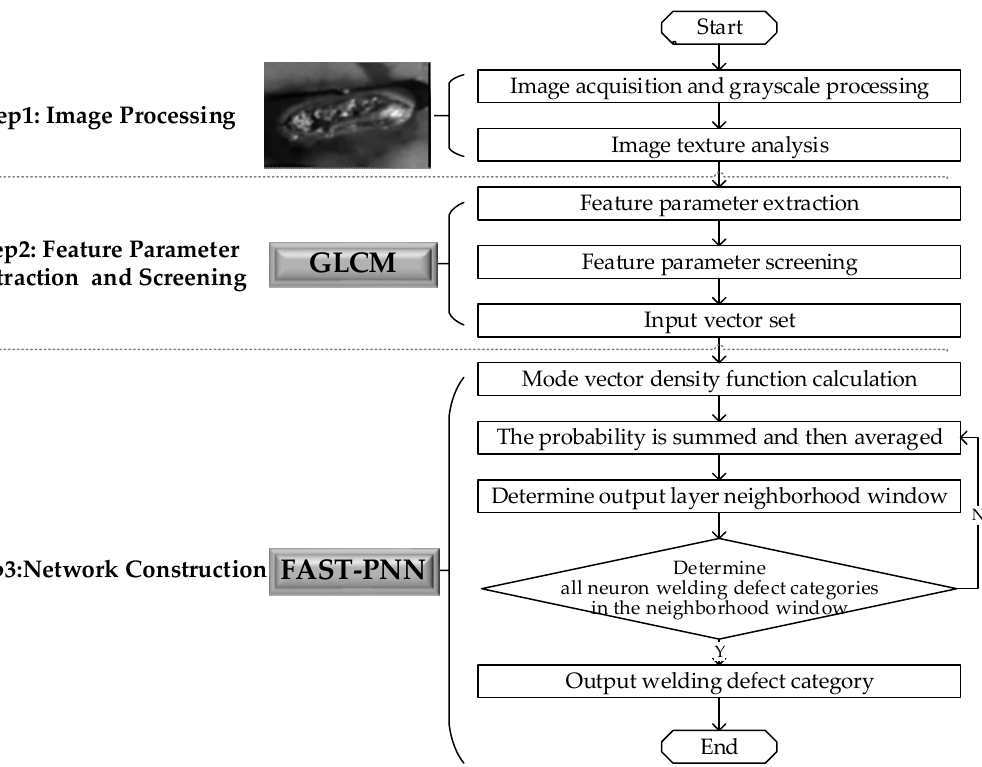
Figure 2. Working steps of welding defect recognition model based on FAST-PNN model.